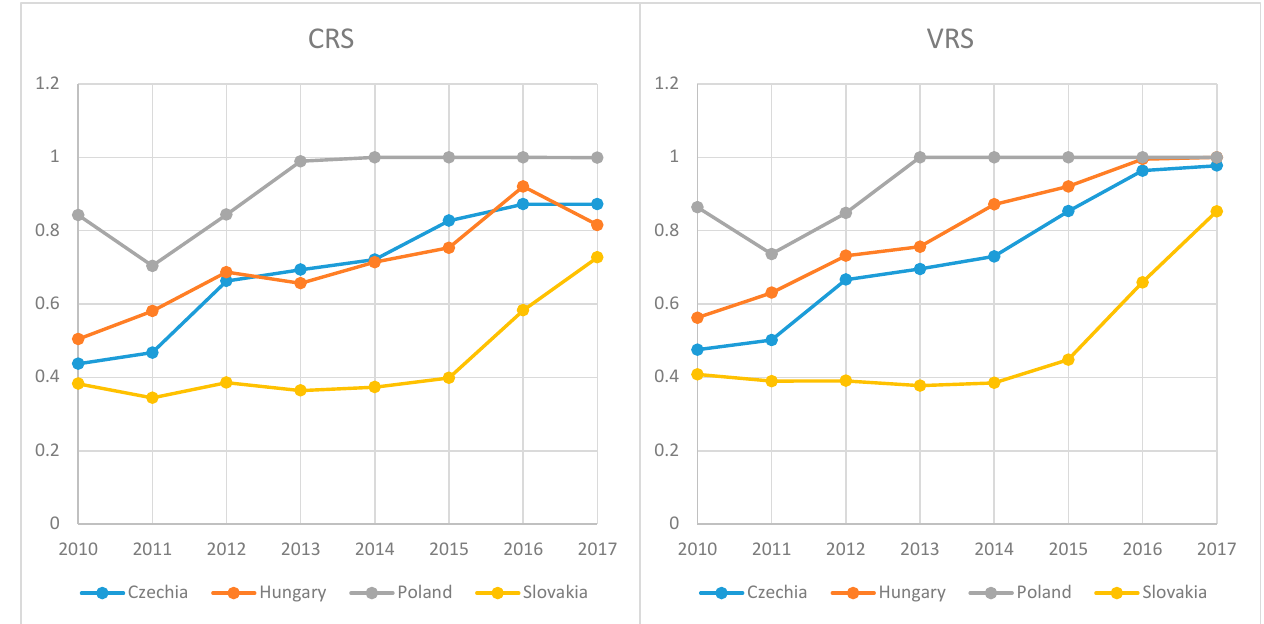
Figure 2. Circular efficiency results of V4 countries.